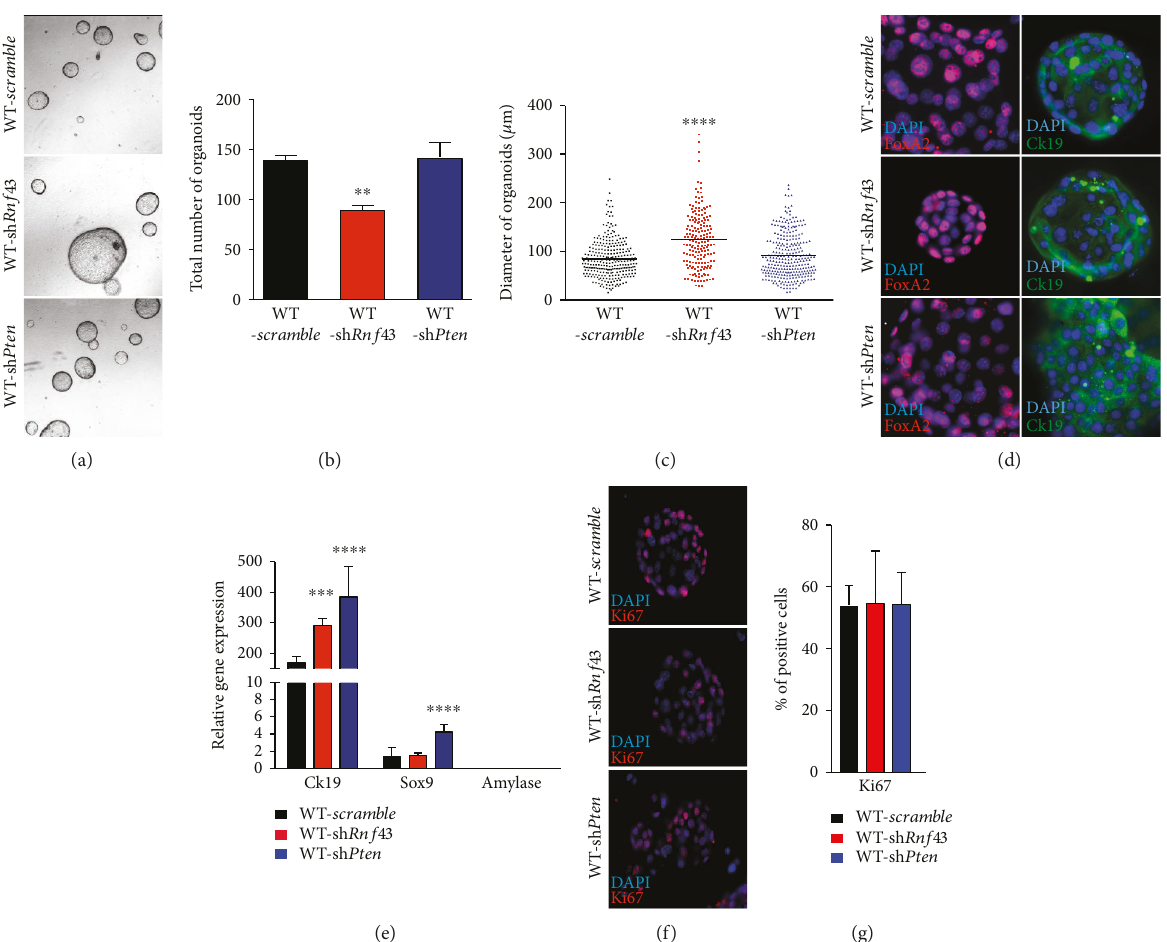
Figure 2: Pten and Rnf43 loss supports ductal features in wild-type organoid cultures. (a) Representative pictures of organoids with shRNA knockdown of Pten (WT-sh Pten ) or Rnf43 (WT-sh Rnf43 ) compared to WT scramble control after six days of culture (40x magni fi cation). (b) Signi fi cantly decreased organoid growth rate after knockdown of Rnf43 ( p = 0 0071 ). (c) RNF43 de fi ciency signi fi cantly increases the diameter of ductal organoids compared to WT scramble ( p ≤ 0 0001 ). (d) Immuno fl uorescence stainings of shRNA-mediated knockdown Pten and Rnf43 organoids reveal the expression of FOXA2 and CK19 (400x magni fi cation). (e) The knockdown of Pten (WT-sh Pten blue bar) signi fi cantly increases the expression of CK19 ( p ≤ 0 0001 ) and SOX9 ( p ≤ 0 0001 ) and for CK19 ( p = 0 001 ) in case of Rnf43 (WT-sh Rnf43 red bar) knockdown compared to WT scramble (black bar). (f) Ki-67 immunostaining analyses of shRNA-mediated knockdown of Rnf43 and Pten in WT organoids (400x magni fi cation). (g) Immunohistochemistry revealed no di ff erences in the percentage of Ki-67-positive cells in WT-sh Pten (blue bar) or WT-sh Rnf43 (red bar) compared to the scramble control (black bar). For statistical analysis, two-tailed Student ’ s t -test was used. p < 0 05 was considered to be statistically signi fi cant. Error bars represent the standard errors of the